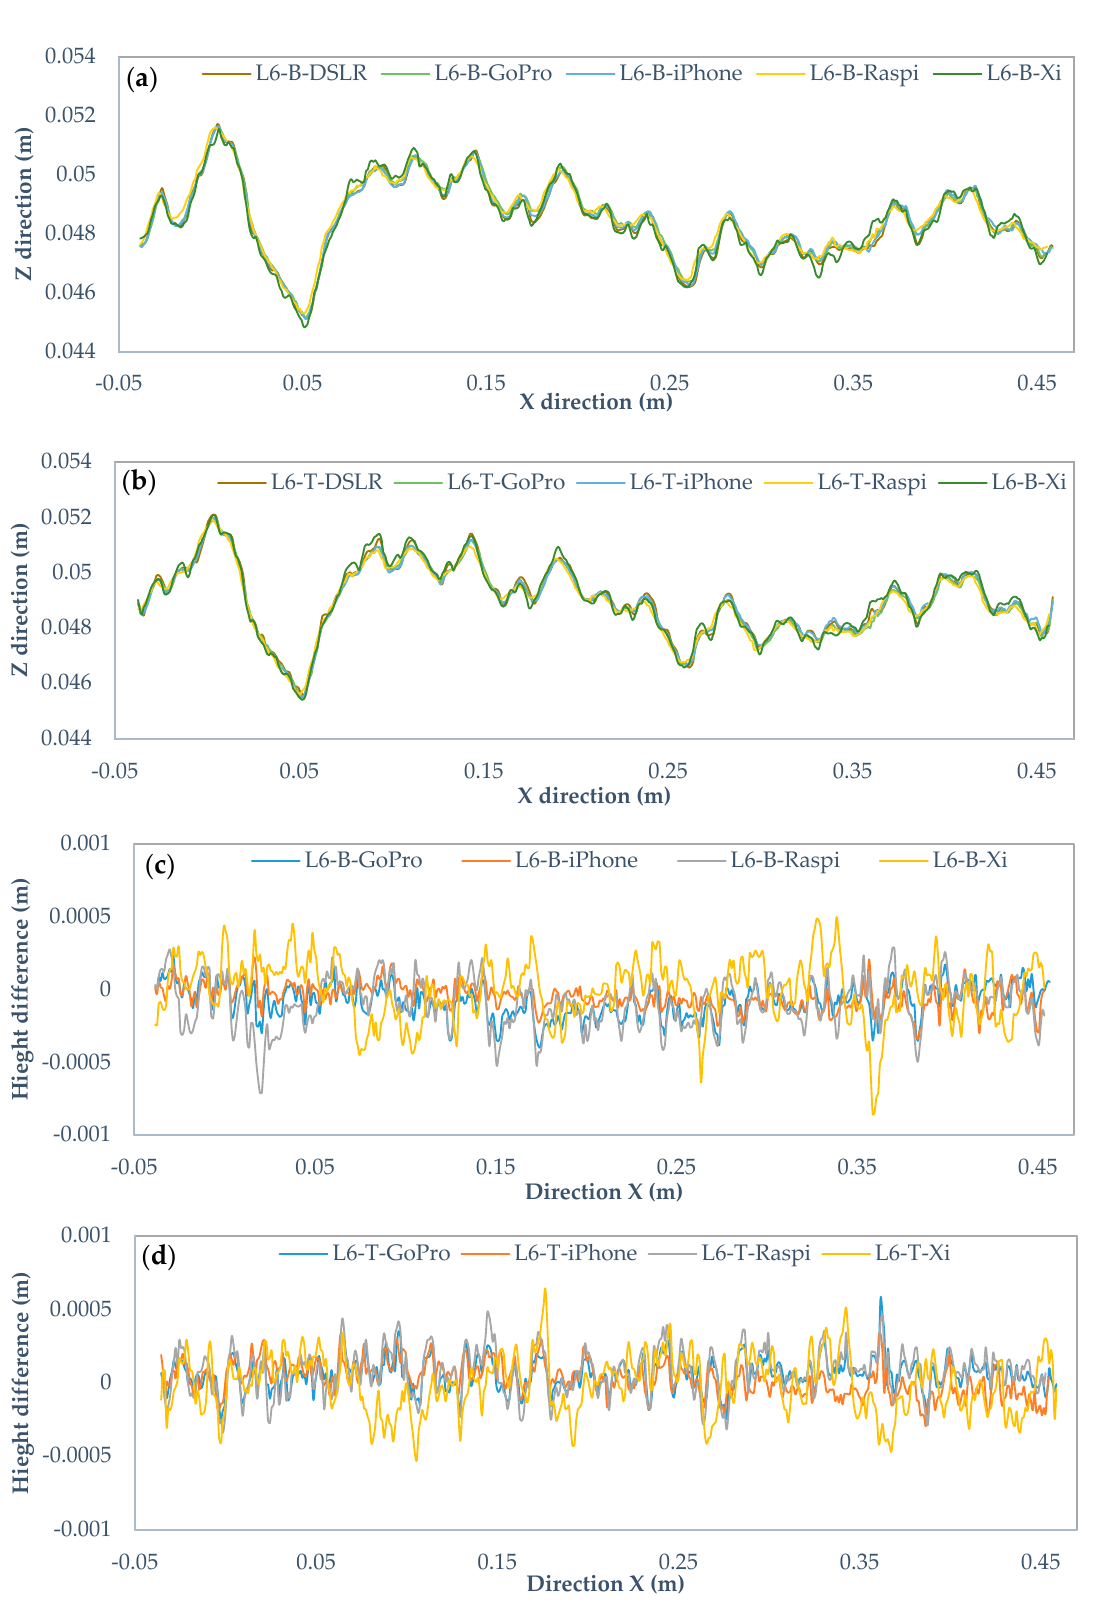
Figure 15. Comparison of the Canon EOS 5DS R DSLR and cameras profiles with 0.5 mm rasteriza ‐ tion grid interval. ( a ) Original profiles of bottom surface, ( b ) top surface, ( c ) height differences of bottom profiles, and ( d ) top profiles.